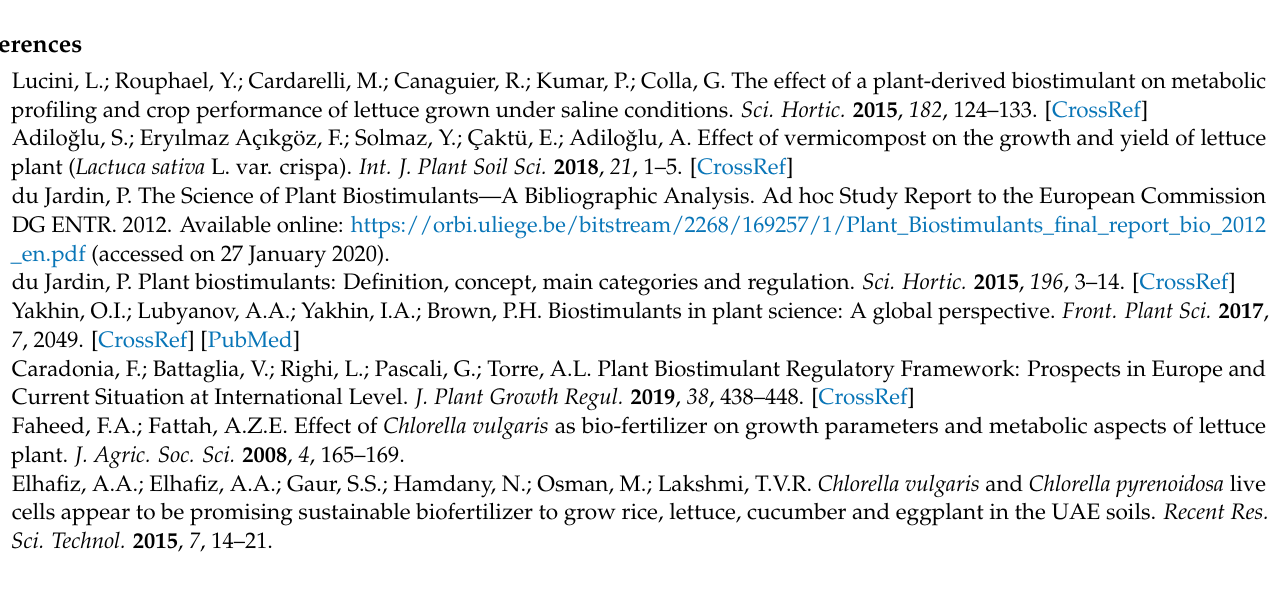
Table S1: Distri-bution of C intensity of 13C NMR of biomass of Chlorella vulgaris (CV) and its extract (CVextr). Table S2: Element composition (%) of biomass of Chlorella vulgaris (CV) and its extract